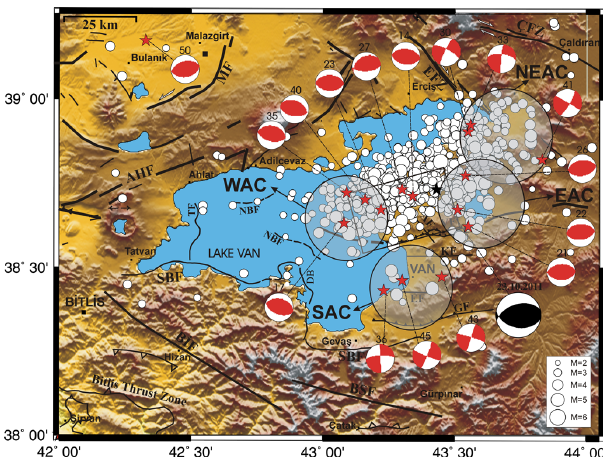
Fig. 3. Local tectonic features of the Lake Van area and the epicen- tre distribution of three day-long M < 4.6 aftershocks of the 23 Oc- tober 2011 Van earthquake (black star) along with the M ≥ 4.6 af- tershocks until April 2012. These aftershocks are represented with white circles excluding the M ≥ 4.6 aftershocks with known source mechanisms (red-white beach balls), which are indicated by red stars. The black-white beach ball and the rectangle represent the source mechanism and surface projection of the rupture plane, re- spectively, of the 2011 Van earthquake used in the stress calcula- tions. Four aftershock clusters identified regarding the source mech- anisms are encircled and named as eastern (EAC), western (WAC), southern (SAC) and northeastern (NEAC) aftershock clusters. The aftershocks are taken from Kandilli Observatory and Earthquake Research Institute and USGS-NEIC catalogues. The aftershock fo- cal mechanisms are from the GCMT catalogue. See caption of Fig. 2 for the other source of information and abbreviations and the text for